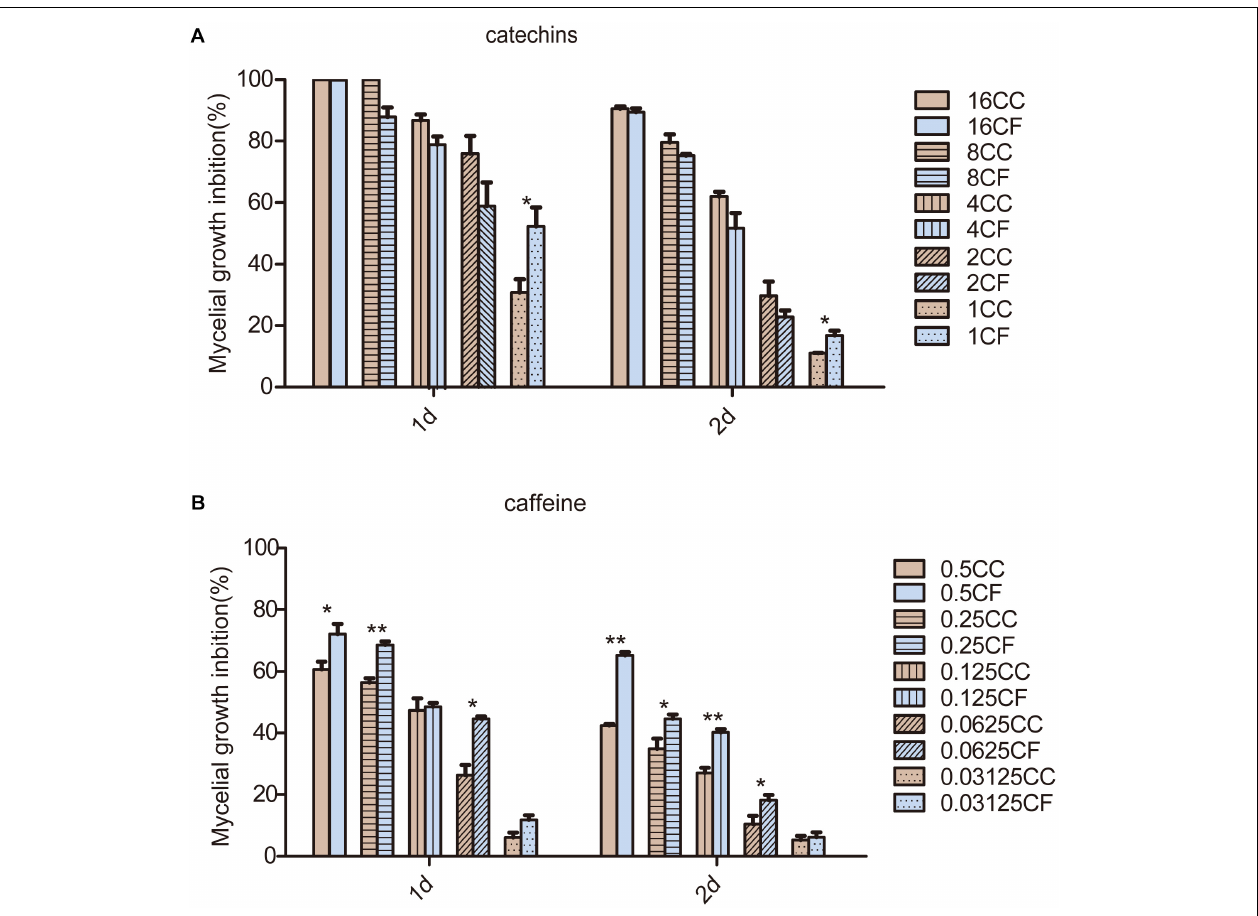
FIGURE 3 | Effects of two compounds on mycelia growth of C. camelliae and C. fructicola in vitro . (A) The mycelial growth inhibition of CC and CF by catechins; (B) The mycelia growth inhibition of CC and CF by caffeine. The numbers in the legend represent treatment concentrations (mg · mL − 1 ); ∗ P < 0.05 and ∗∗ P < 0.01 by the LSD test. The error bars represent SEM; n = 3.